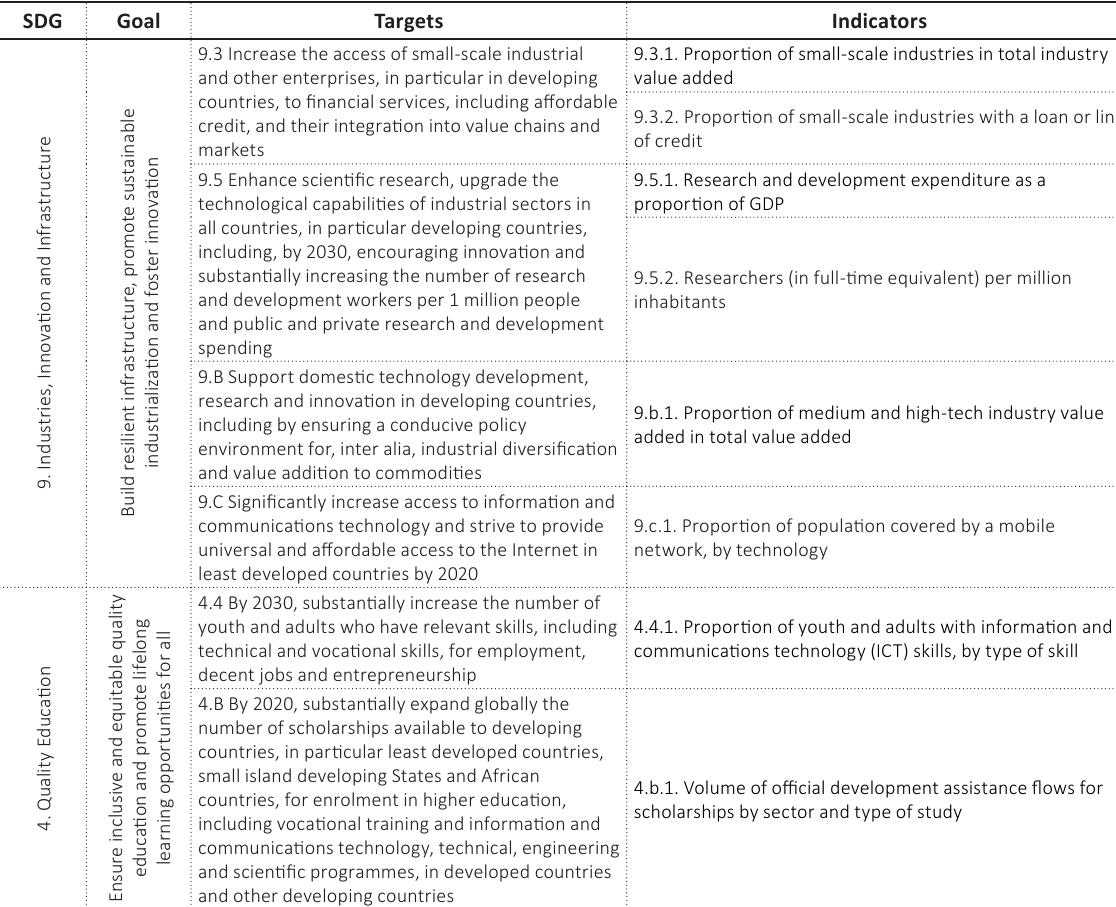
Table C1 (cont.). Goals, targets, and indicators of SDG16, SDG4, SDG8, SDG9, presented in order of SDGs statistical link strength with the FinTech PEST